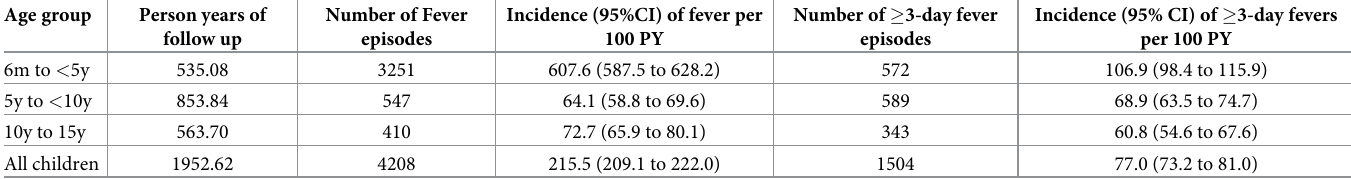
Table 2. Incidence of fevers by age-categories in the cohort (n = 984). Age group Person years of follow up